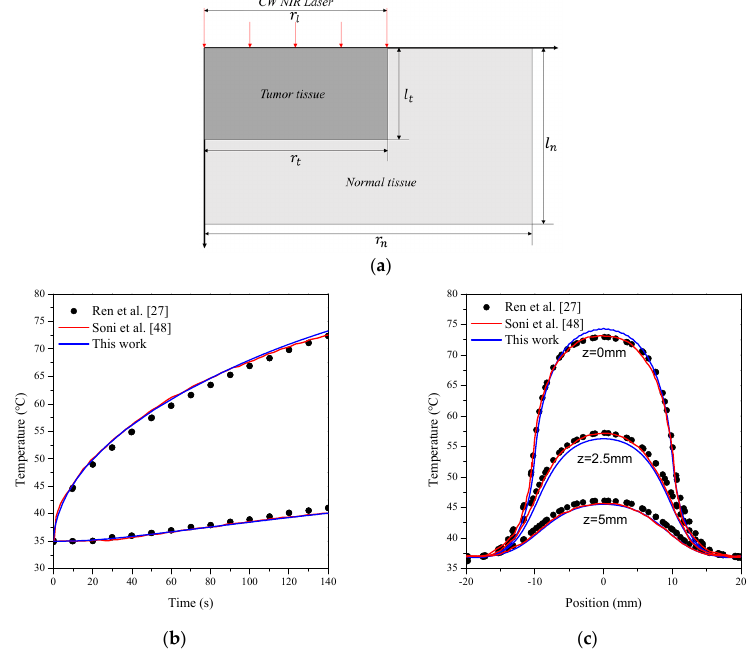
Figure 5. ( a ) A schematic of the geometry and ( b , c ) comparison of results for the verification of numerical analysis